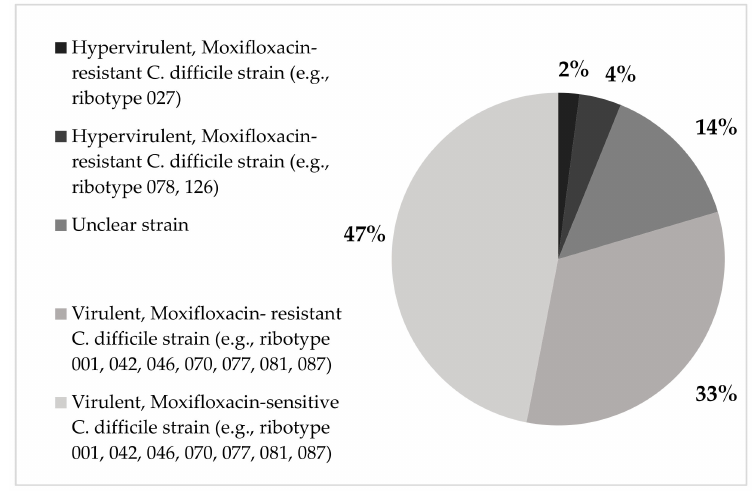
Figure 2. Distribution of di ff erent C. di ffi cile